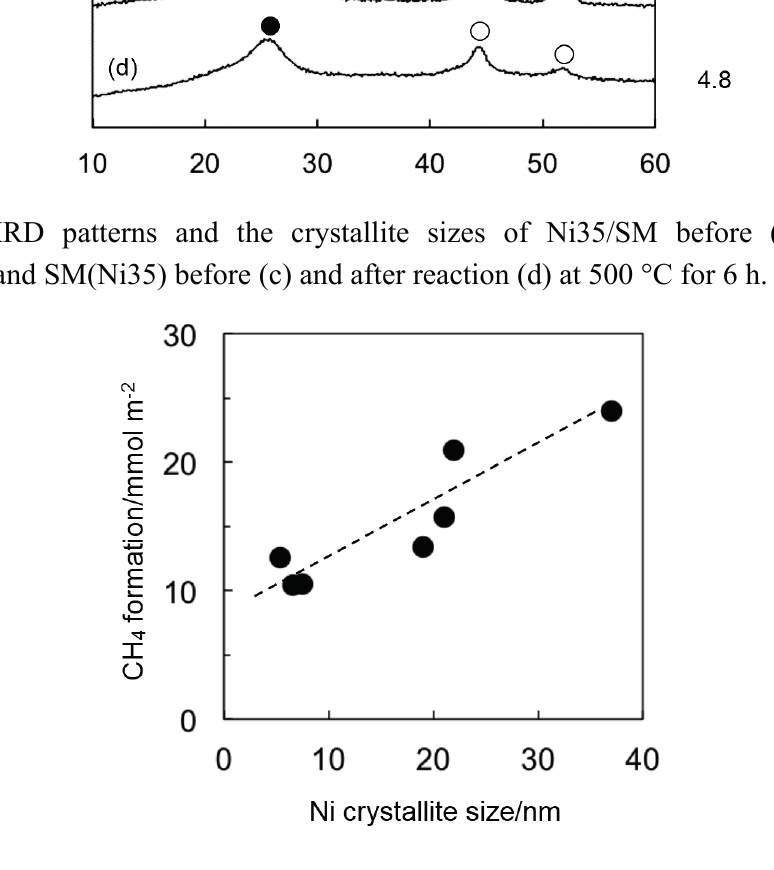
Figure 5. Relationship between the crystallite size of Ni particles and the amount of CH 4 formed (the amount of carbon deposits) per exposed Ni surface